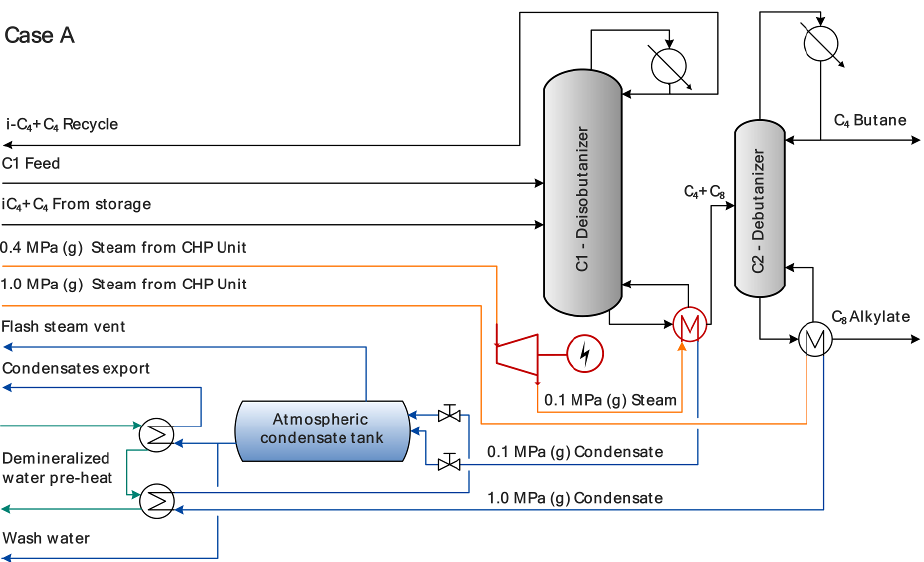
Figure 6. Additional steam turbine installation in the alkylation process: “Case A”. New equipment, compared to the process layout depicted in Figure 5, is highlighted in red.